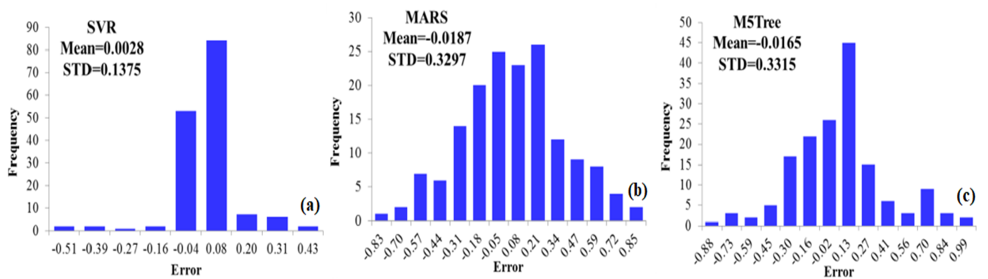
Figure 14. Distribution of the errors for the predicted and true data of CVDs in the training process using SVR ( a ), MARS ( b ) and M5Tree ( c ) of ML methods; see abbreviations in